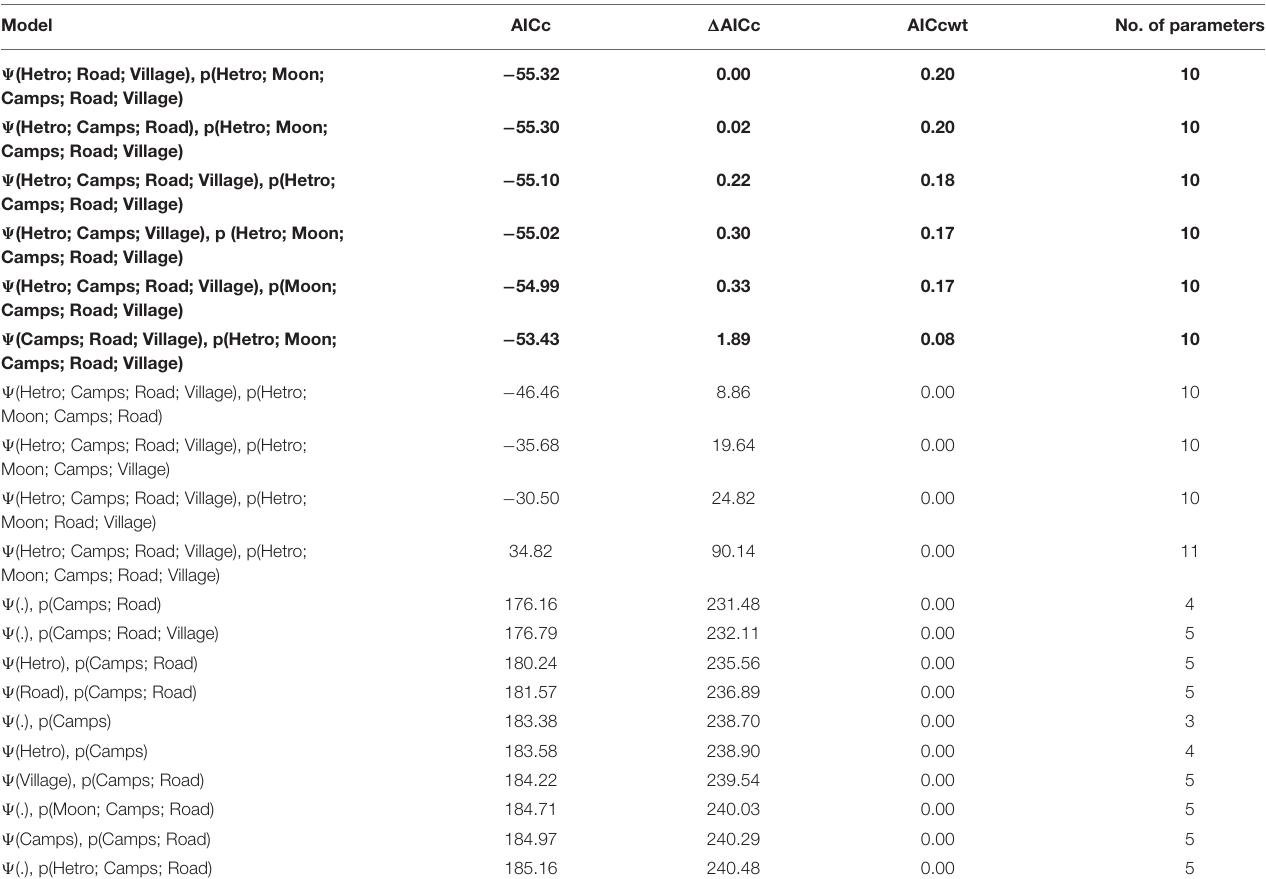
TABLE 3 | Top 20 best fitting models used to detect hunting detectability ( p ) and occupancy ( 9 ) across the Gran Caldera de Luba Scientific Reserve, Bioko Island, Equatorial Guinea.